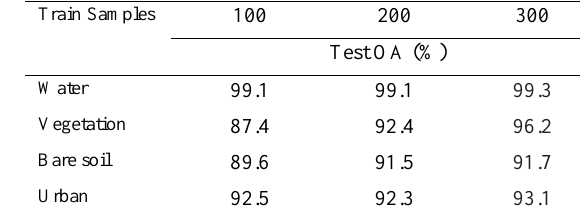
Table 4. Obtained classification results of every class for